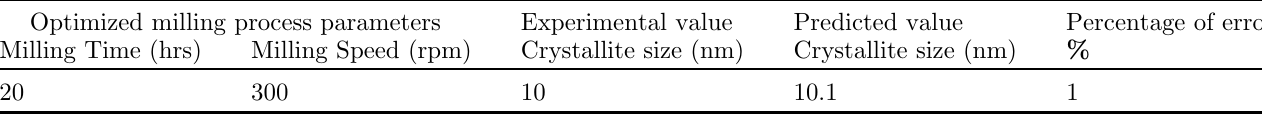
Table 6. Best Parameters results of con fi rmation test for crystallite